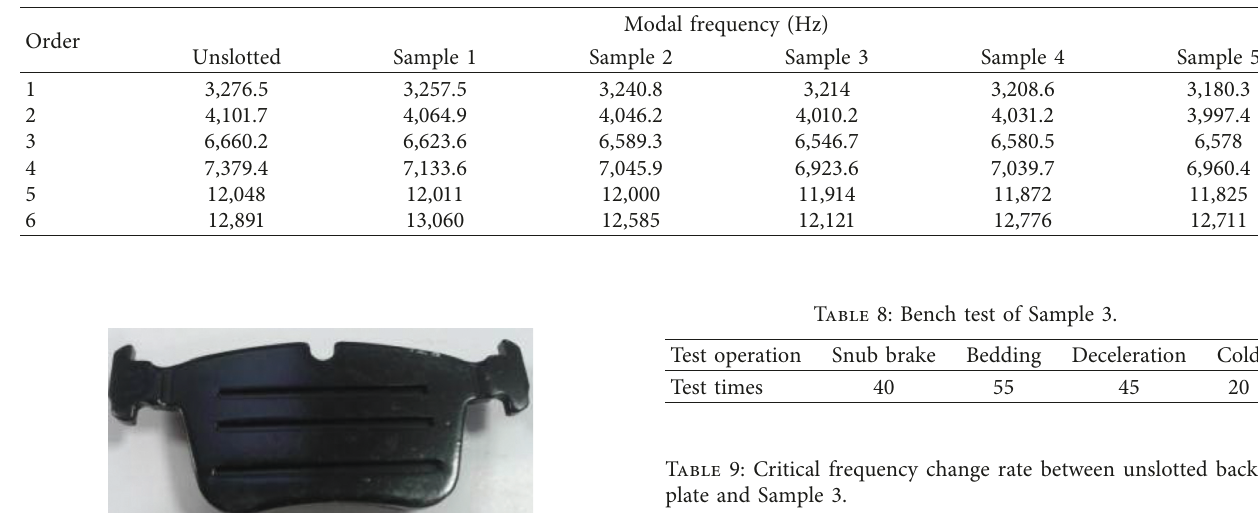
Table 7: Comparison of critical modal frequencies between slotted backplate and unslotted backplate.